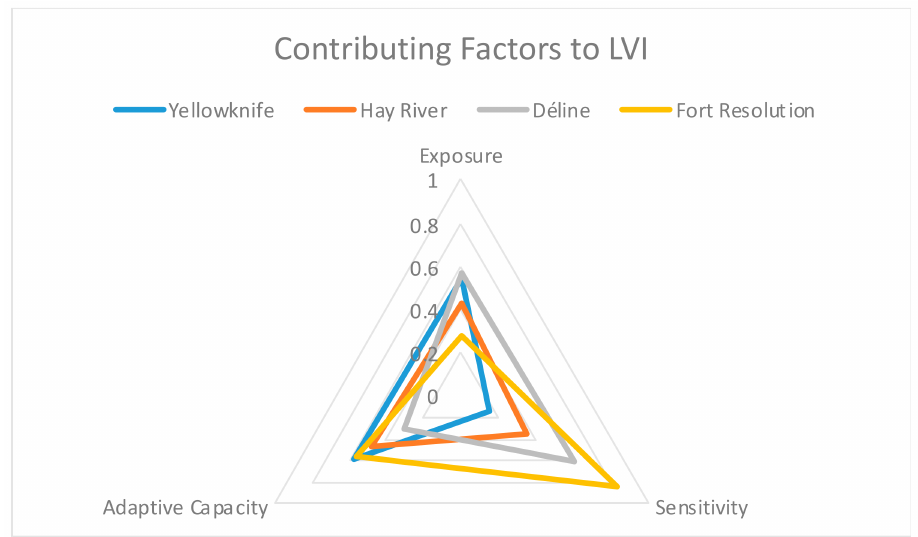
Figure 10. The overall rank of each community’s livelihood vulnerability index, indicating each com- munity’s vulnerability to November snowstorms by taking into account the three major contributing factors (adaptive capacity, sensitivity, and